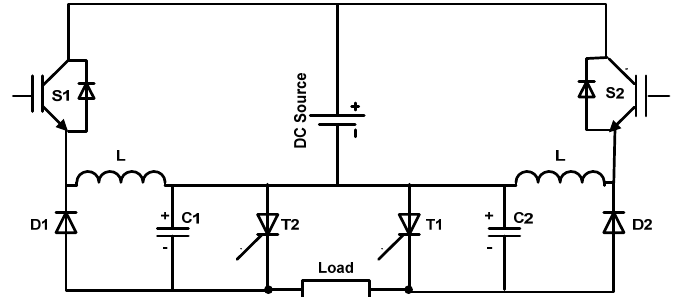
Figure 5. The Adopted Buck – Boost DC – AC Converter Circuit Diagram.